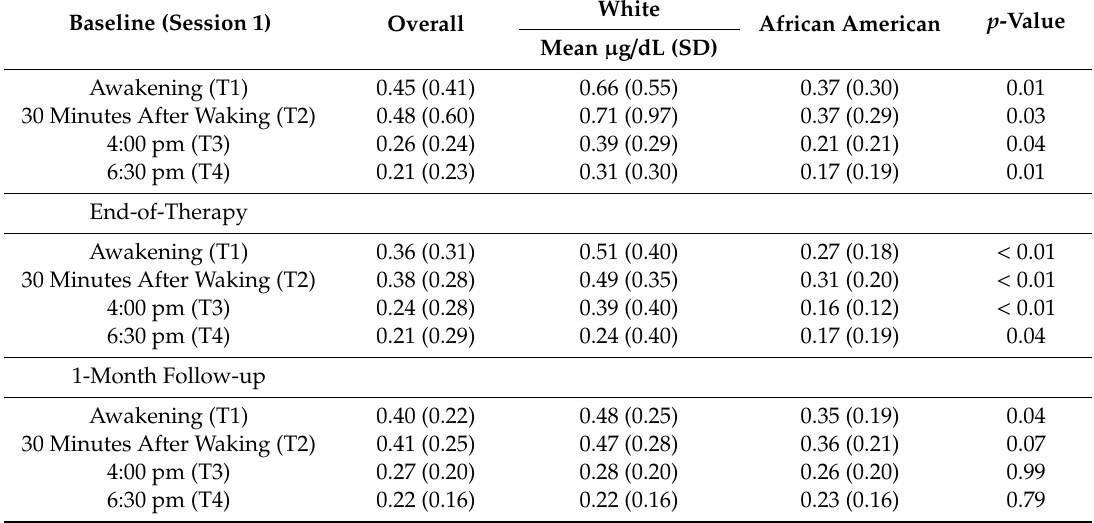
Table 2. Salivary Cortisol Concentrations by Racial / Ethnic Group.